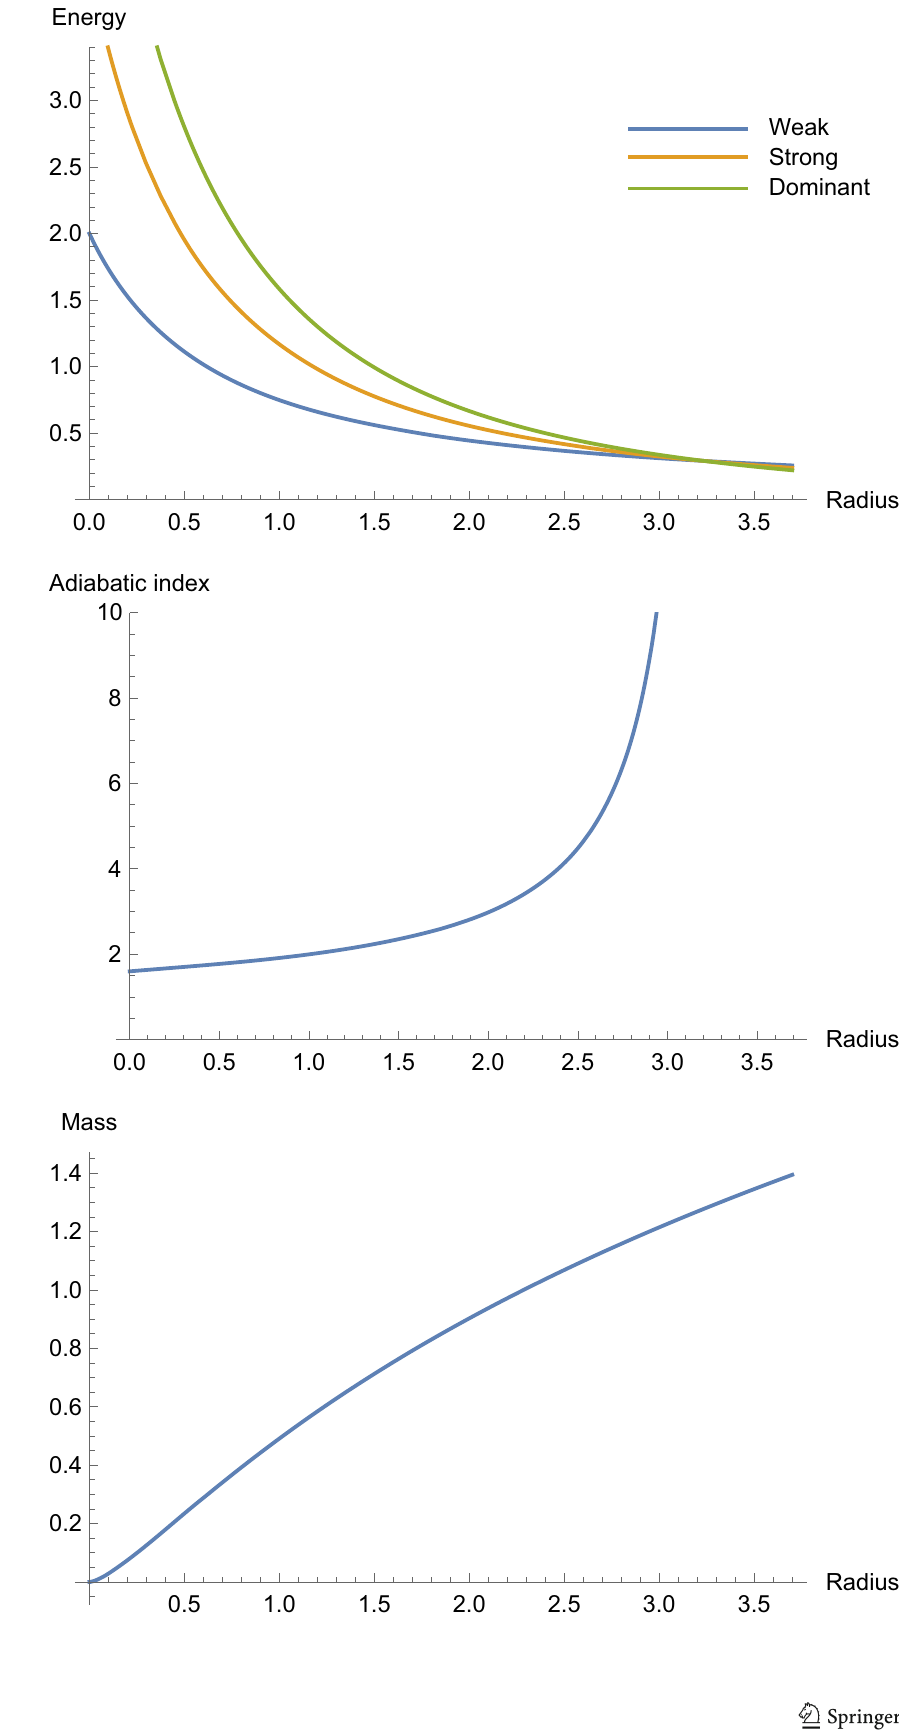
Fig. 4 Energy conditions versus the radial variable x